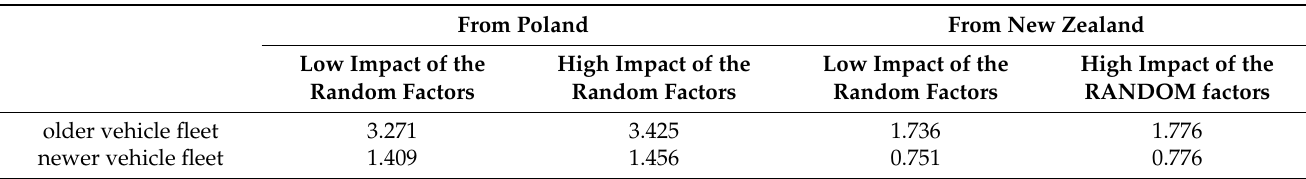
Figure 5. CO 2 emission values per tonne of goods transported for analysed scenarios for apple suppliers. Source: own elaboration. Table 4. CO 2 emission values per kilometre of the supply chain for analysed scenarios for apple